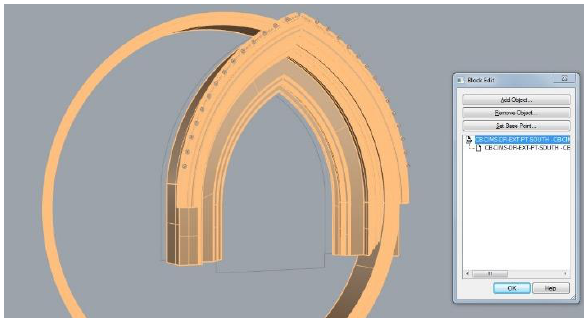
Figure 6. Correcting model errors from the export process.